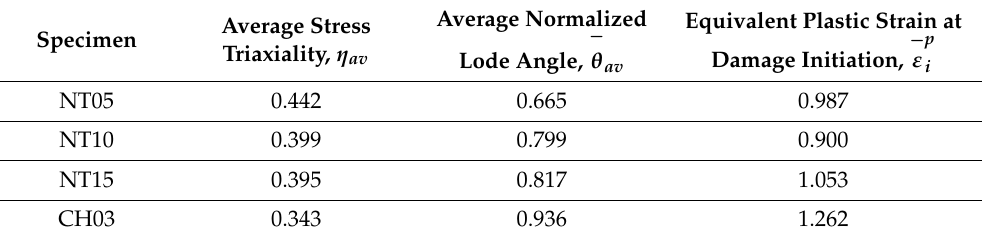
Table 3. Average stress triaxiality, average normalized Lode angle, and equivalent plastic strain at damage initiation of 304L stainless steel. The average values were derived considering the loading history.